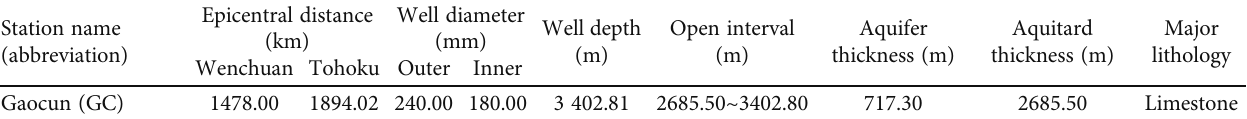
Figure 1: Original water level of well Gaocun (from January 1st, 1981, to May 9th, 2020) with an obvious downward trend. The gaps indicate invalid original data records. The vertical dashed lines represent the start time of the 2008 M w 7.9 Wenchuan earthquake and the 2011 M w 9.1 Tohoku earthquake, which had not caused any in fl uence on the water level. (GC is a nonartesian well; thus, the y -coordinate axis indicates the distance from the water-level surface to the ground.) Table 1: Basic information of well